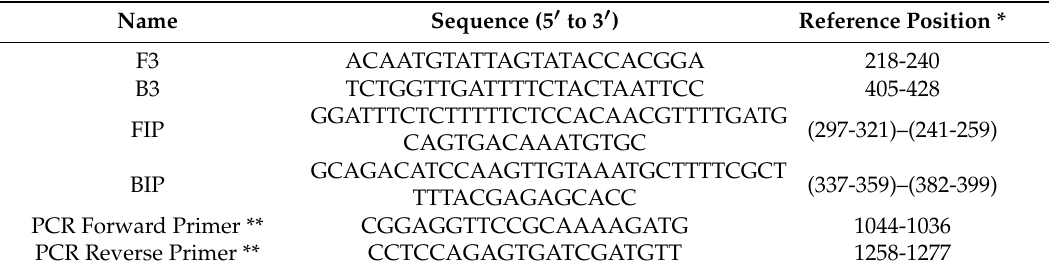
Table 1. Corresponding primers and probes used for amplification of L. monocytogenes